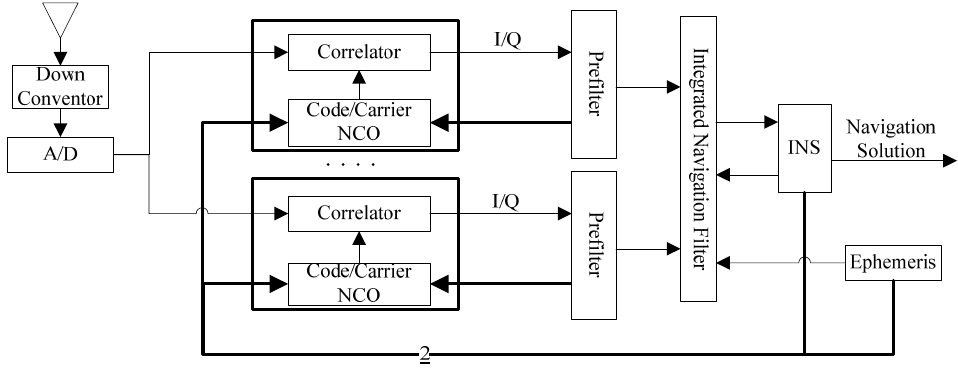
Figure 2. Federated design of ultra-tight GPS/INS